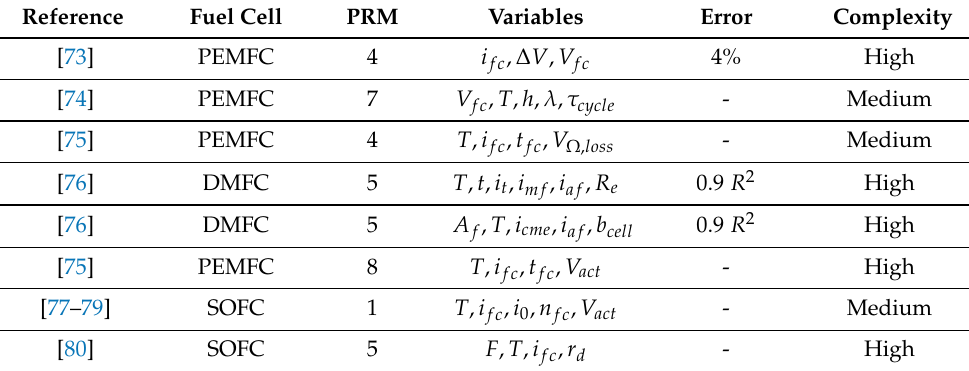
Table 6. Degradation models with electrical-related input for fuel cells. DMFC: direct methanol fuel cell; SOFC: solid oxide fuel